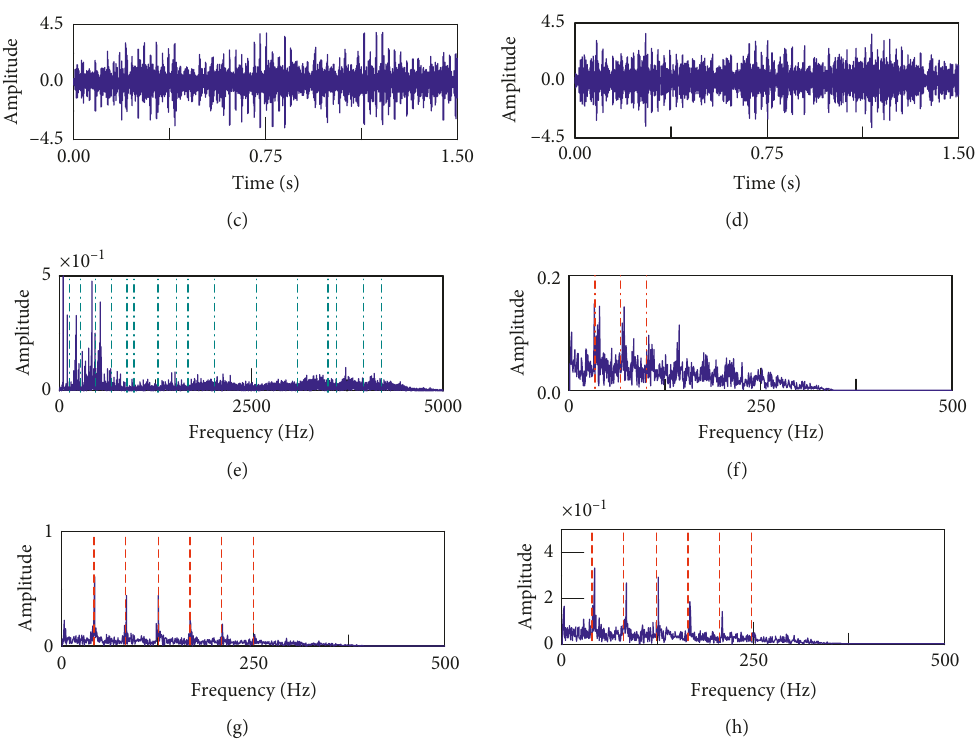
Figure 26: Results obtained by the traditional EWT: (a) SSP (green dashed line: the detected threshold by k -means clustering); (b–d) sub- band signals; (e) detected boundaries (green dash-dotted lines); (f–h) squared envelope spectra (red dashed lines: f BPFO and its harmonics; red dash-dotted lines: f BSF and its